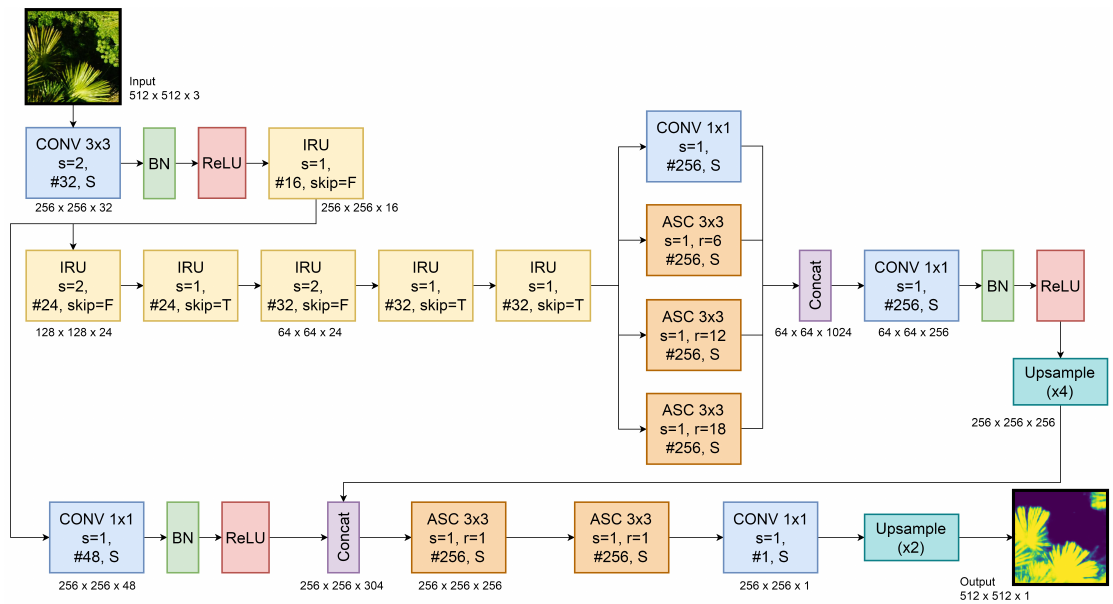
Figure 7. The proposed network architecture. It uses regular convolutions (“CONV”), inverted residual units (“IRU”) and atrous separable convolutions